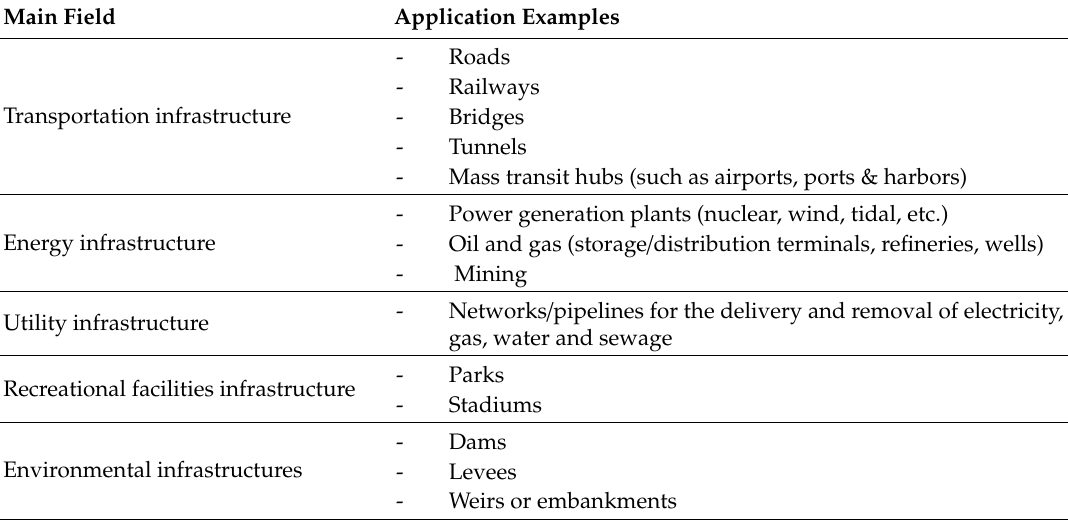
Table 1. Main application fields of Building Information Modeling (BIM) concept at infrastructure scale. Main